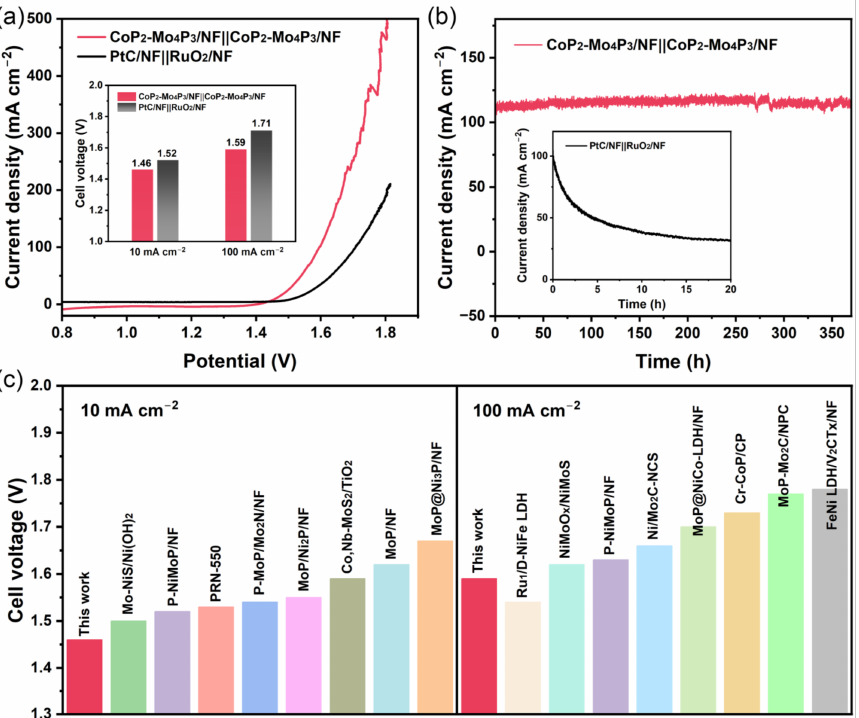
Figure 5. ( a ) LSV polarization curves for the CoP 2 -Mo 4 P 3 /NF||CoP 2 -Mo 4 P 3 /NF and PtC/NF||RuO 2 /NF in a 1.0 M KOH electrolyte. Inset: comparison of the driving voltages re- quired to reach different current densities for different catalysts, ( b ) Stability measurements of CoP 2 -Mo 4 P 3 /NF||CoP 2 -Mo 4 P 3 /NF and PtC/NF||RuO 2 /NF (inset), ( c ) Cell voltage comparison of CoP 2 -Mo 4 P 3 /NF||CoP 2 -Mo 4 P 3 /NF with recently reported state-of-the-art OWS